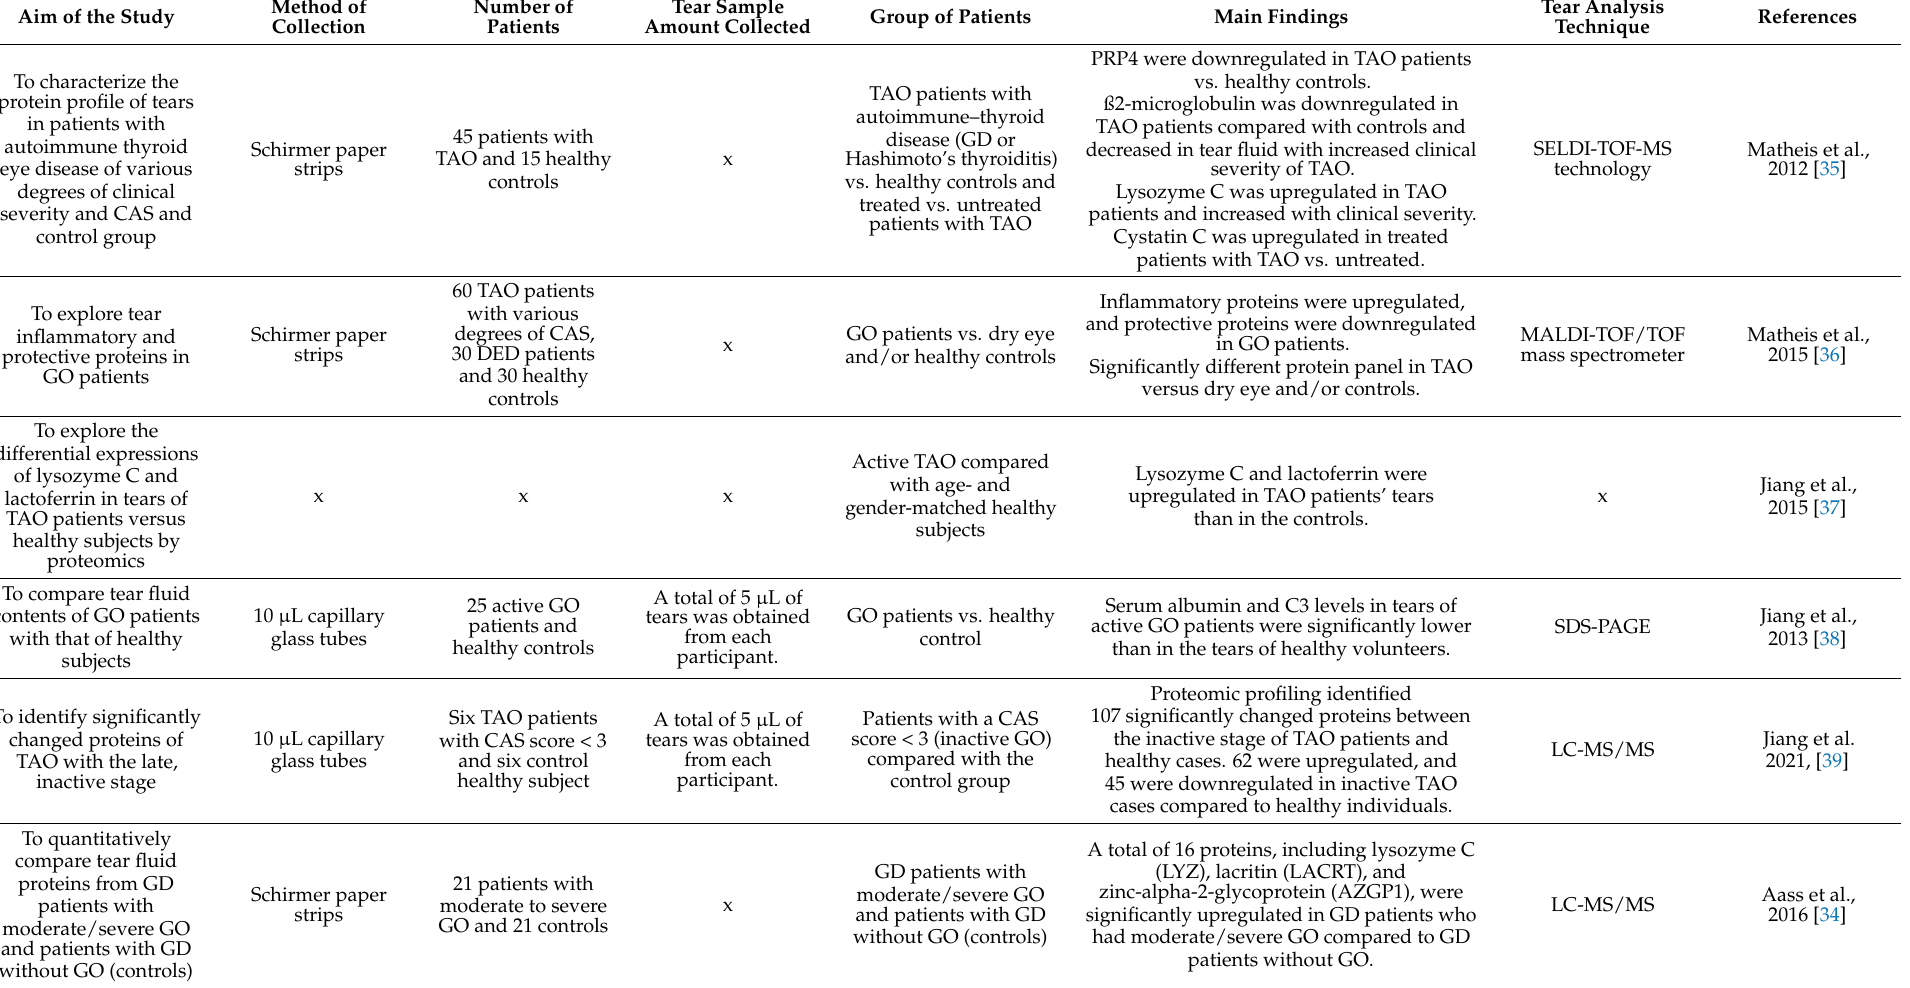
Table 2. Summary of Studies Examining Proteins in Tears of GO